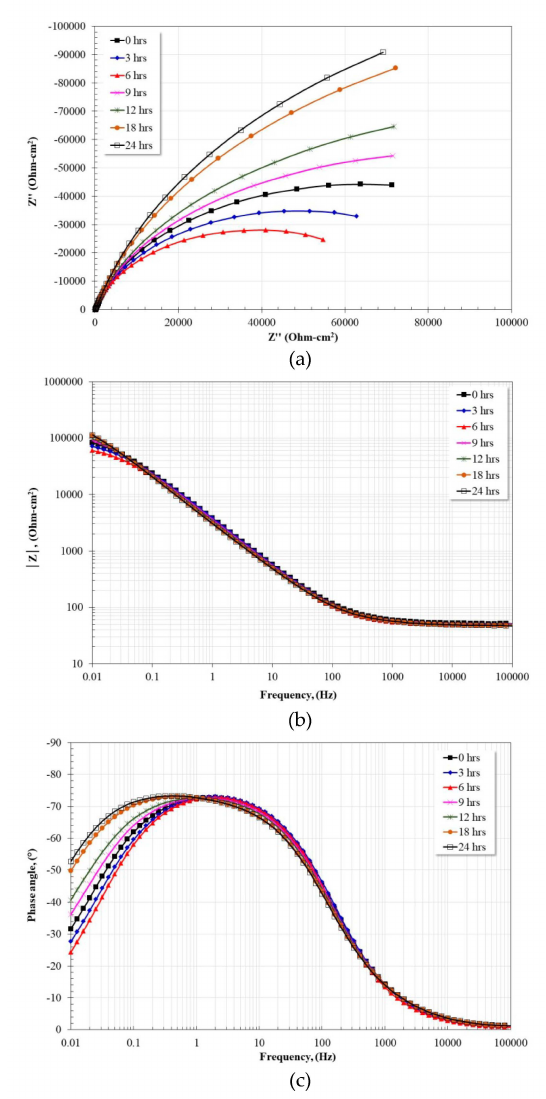
Figure 8. Nyquist ( a ) and Bode ( b , c ) plots for Fe40Al-3Ni exposed in artificial saliva at 37 ◦ C after 24